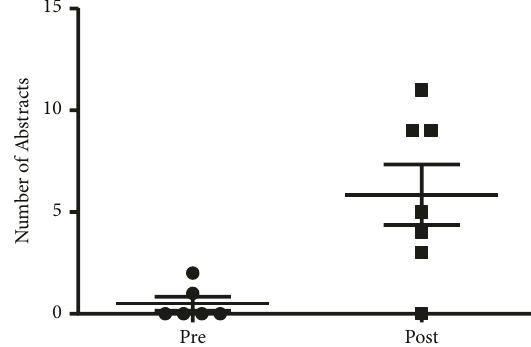
Figure 2: Mean number of abstracts submitted by student-faculty dyads per six months prior to and subsequent to the development